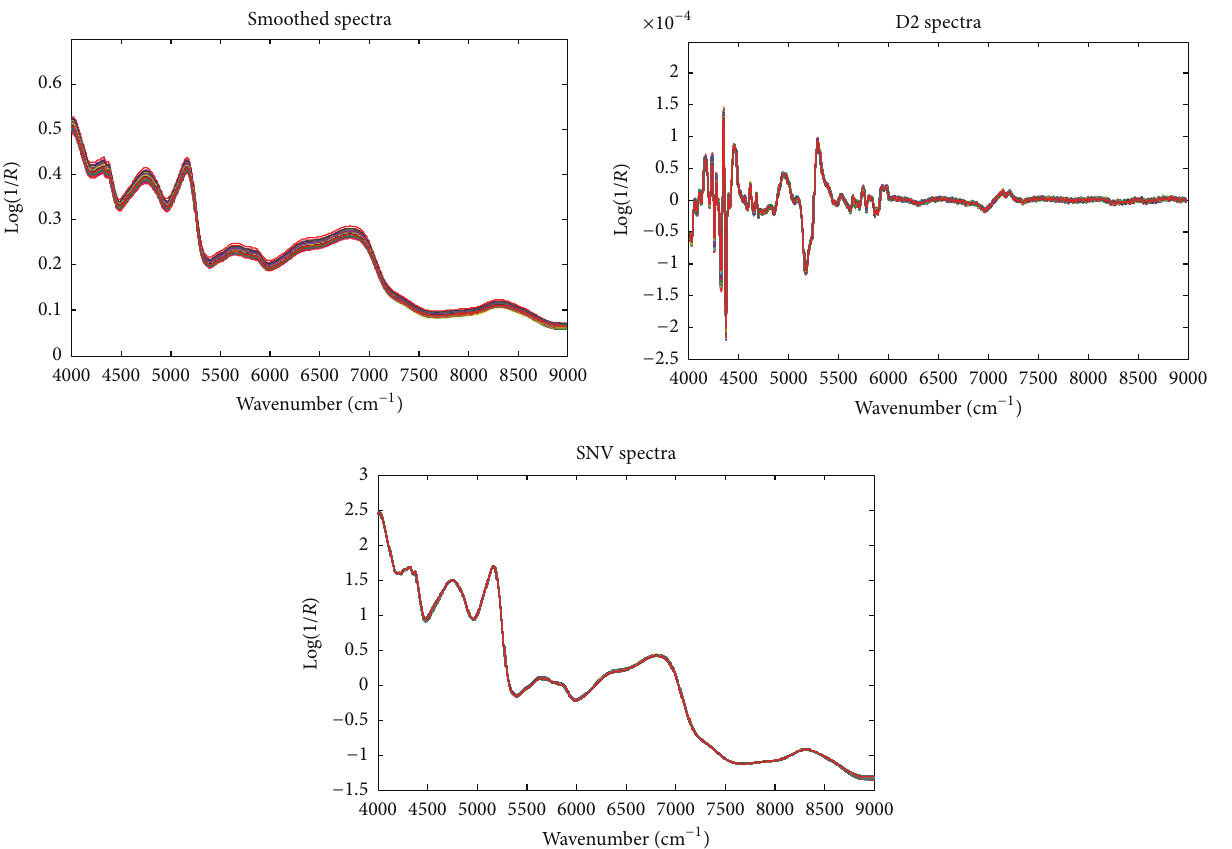
Figure 2: The smoothed, second-order derivative (D2) and standard normal variate (SNV) NIR spectra of 120 adulterated oat flour objects with doping levels ranging from 5% to 50%